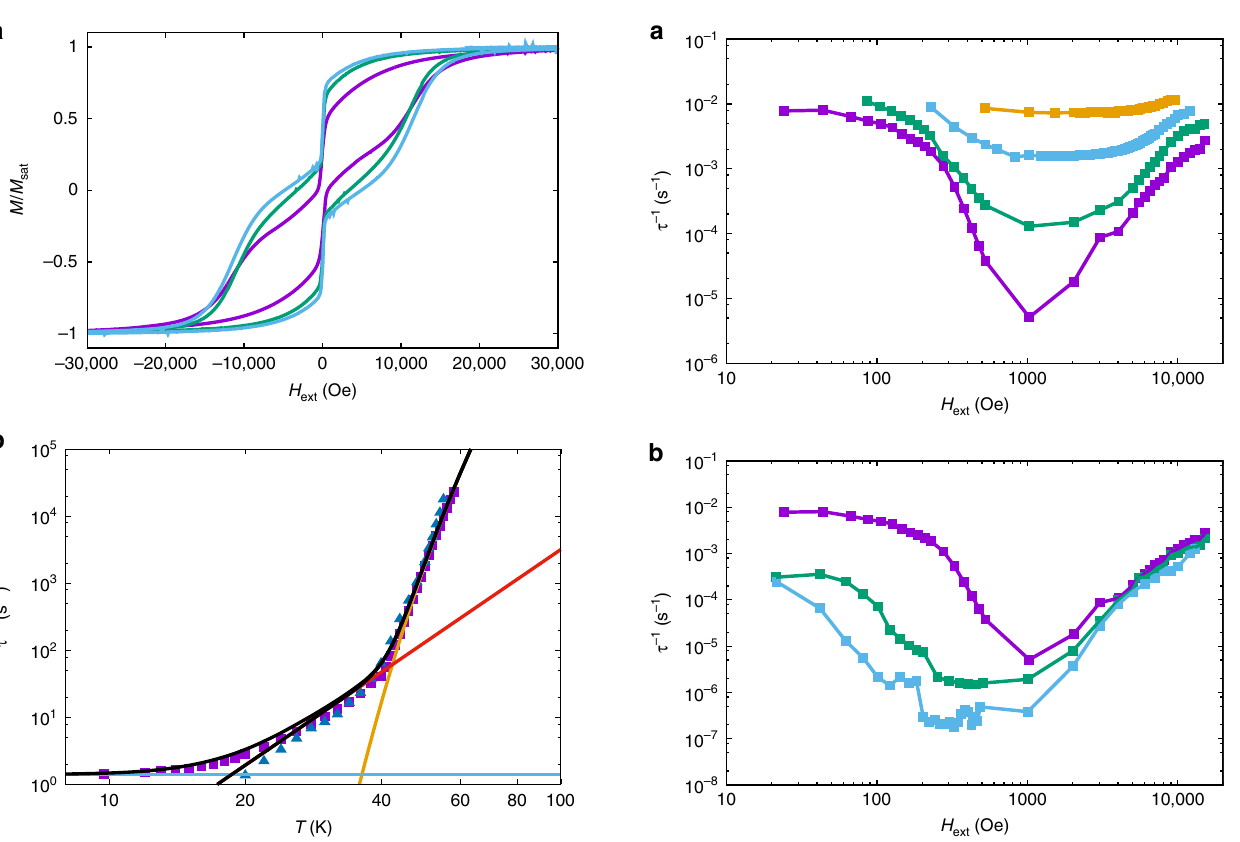
Fig. 2 Magnetic hysteresis and relaxation rate. a Magnetic hysteresis for 1 Fig. 3 Field dependence of magnetic relaxation rate. a Magnetic relaxation (purple), ~9% Dy@ 2 (green, similar concentration to 1a ) and ~5% Dy@ 2 rate for 1 (note log-log scale) at 2 (purple), 4 (green), 6 (light blue) and 8 K (light blue, similar concentration to 1b ) at 2 K with a sweep rate of ~50 Oe s (orange; see Supplementary Fig. 10 for 3, 5, 7, and 9 K data). b Magnetic − 1 . b Magnetic relaxation rate for 1 (purple squares) and 1a (blue triangles) relaxation rate for 1 (purple), 1a (green) and 1b (light blue; note log-log measured by AC magnetometry (note the log-log scale); black line is a fi t scale) at 2 K. Solid lines are a guide for the eye. Error bars are within the with Eq. (1) using the parameters: U eff = 950(20) K, τ 0 = 3(1) × 10 − 12 s, C data = 2(1) × 10 − 6 s − 1 K − n , n = 4.6(2), τ − 1 = 1.4(1) s − 1 ( τ (cid:1) 1 ¼ 0 for 1a ) QTM QTM and D = 0 ( fi xed), orange line is the Orbach component alone, red line is the Raman component alone, blue line is the QTM component alone (for 1 )